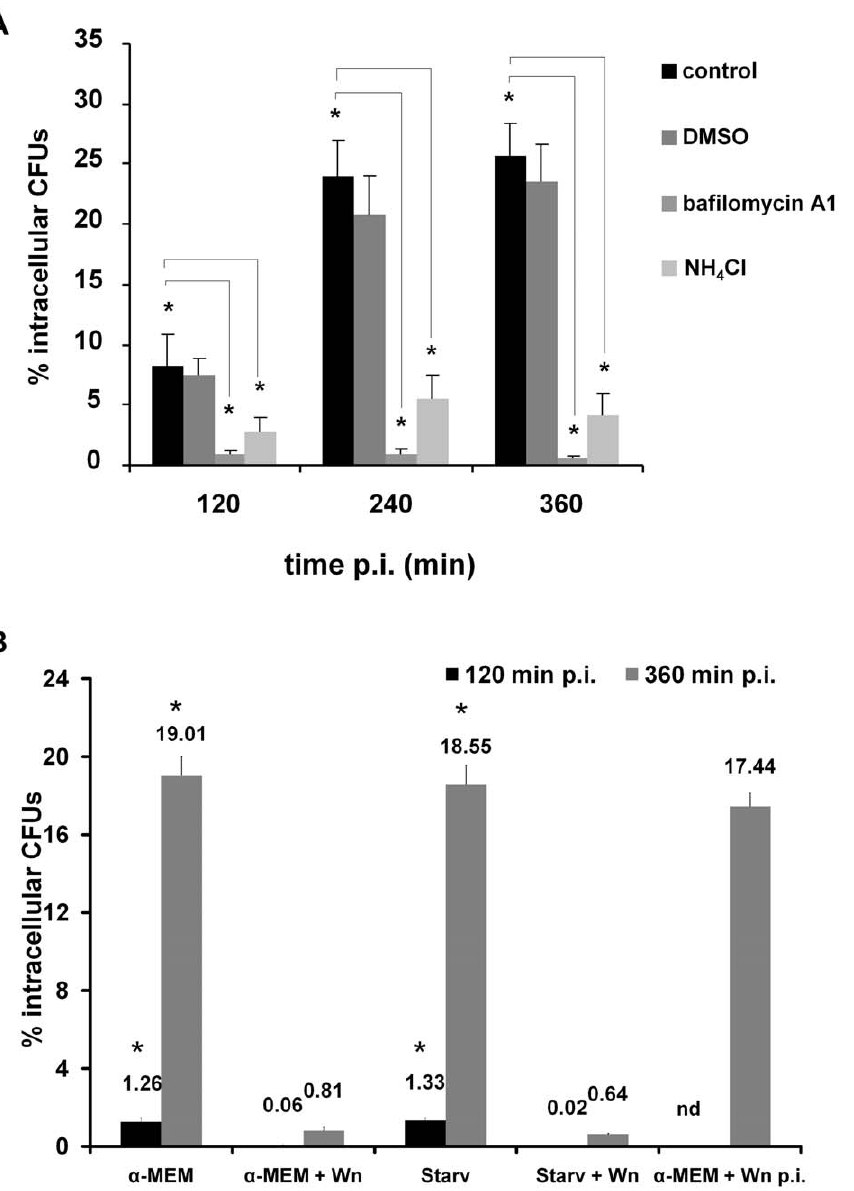
Figure 5. Effect of autophagy inhibitors on Serratia invasion. A) Inhibition or neutralization of vacuolar acidification on Serratia invasion. CHO-EGFP-LC3 cells were maintained in a -MEM, incubated with DMSO 1% (which equals the final concentration of DMSO used as vehicle for bafilomycin A1), 100 nM bafilomycin A1 or 10 mM NH 4 Cl, as indicated in Materials and Methods. Cells were infected with wild-type S. marcescens following the gentamicin protection assay procedure. Invaded cells were lysed with 0.05% Triton X-100 and CFUs were determined on LB agar plates at 120, 240 or 360 min p.i. Percentages were calculated relative to CFUs in the inoculum. The average 6 S.D. is shown for three independent experiments, *p , 0.001. B) Modulation of autophagy on Serratia invasion. CHO-EGFP-LC3 cells were maintained in a -MEM, or pre-treated in EBSS starvation medium (Starv). 100 nM Wortmannin (Wn) was added 2 h previous to the infection assay ( a -MEM + Wn; or Starv + Wn) or at 60 min p.i. ( a -MEM + Wn p.i). Cells were infected with wild-type S. marcescens following the gentamicin protection assay procedure. Invaded cells were lysed with 0.05% Triton X-100 and the CFUs were determined on LB agar plates at 120 or 360 min p.i. The average 6 S.D. is shown for three independent experiments (% intracellular CFUs are indicated above each bar in the graph; nd: not determined, *p ,